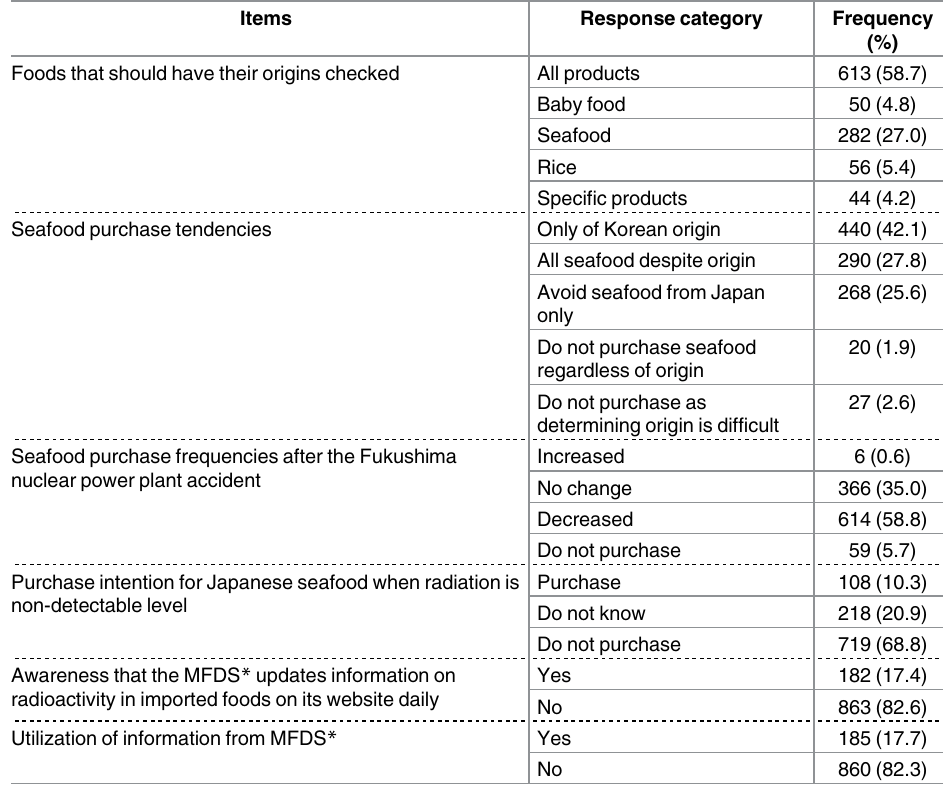
Table 3. Perception of information provisions and seafood purchase